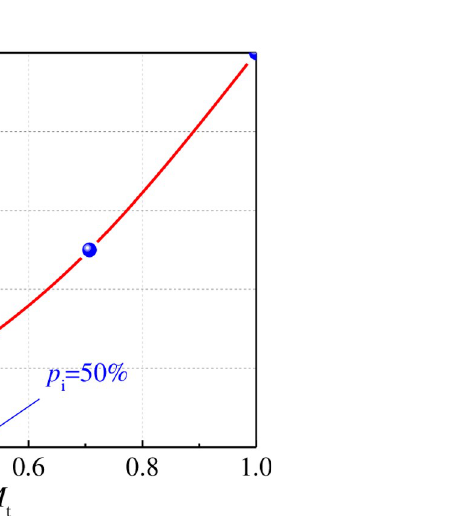
Fig 4. Principle of calculating the d 50 value of the specimen.